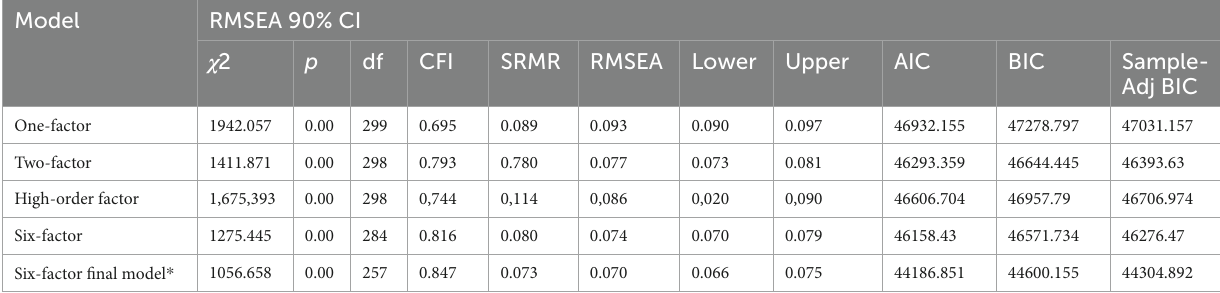
TABLE 3 Factorial validity.